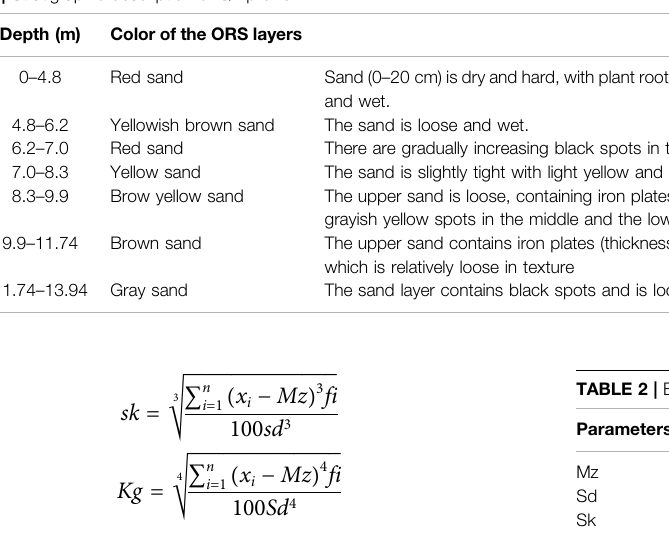
TABLE 1 | Stratigraphic description of QF pro fi le.